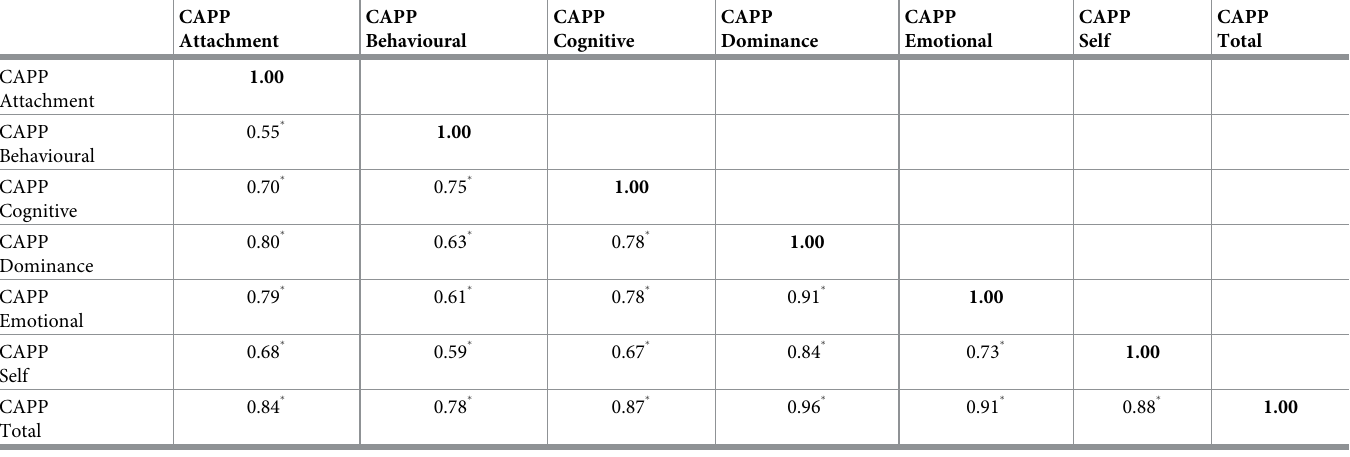
Table 4. Correlations among CAPP total and domain scores for the whole sample. CAPP